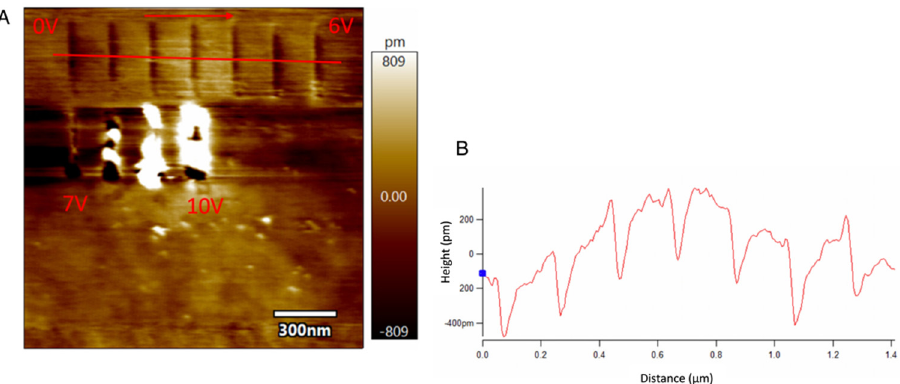
Figure 6. The scratched lines and the line profile with different tip voltage over silicon substrate with diamond tip: ( A ) The scratched lines over silicon using single crystal diamond AFM tip with different tip voltage ranging from 0 V to 10 V with constant velocity ( B ) The line profile of the trenches (non-flattened). F T = 4 μ N and the humidity is ~75%.